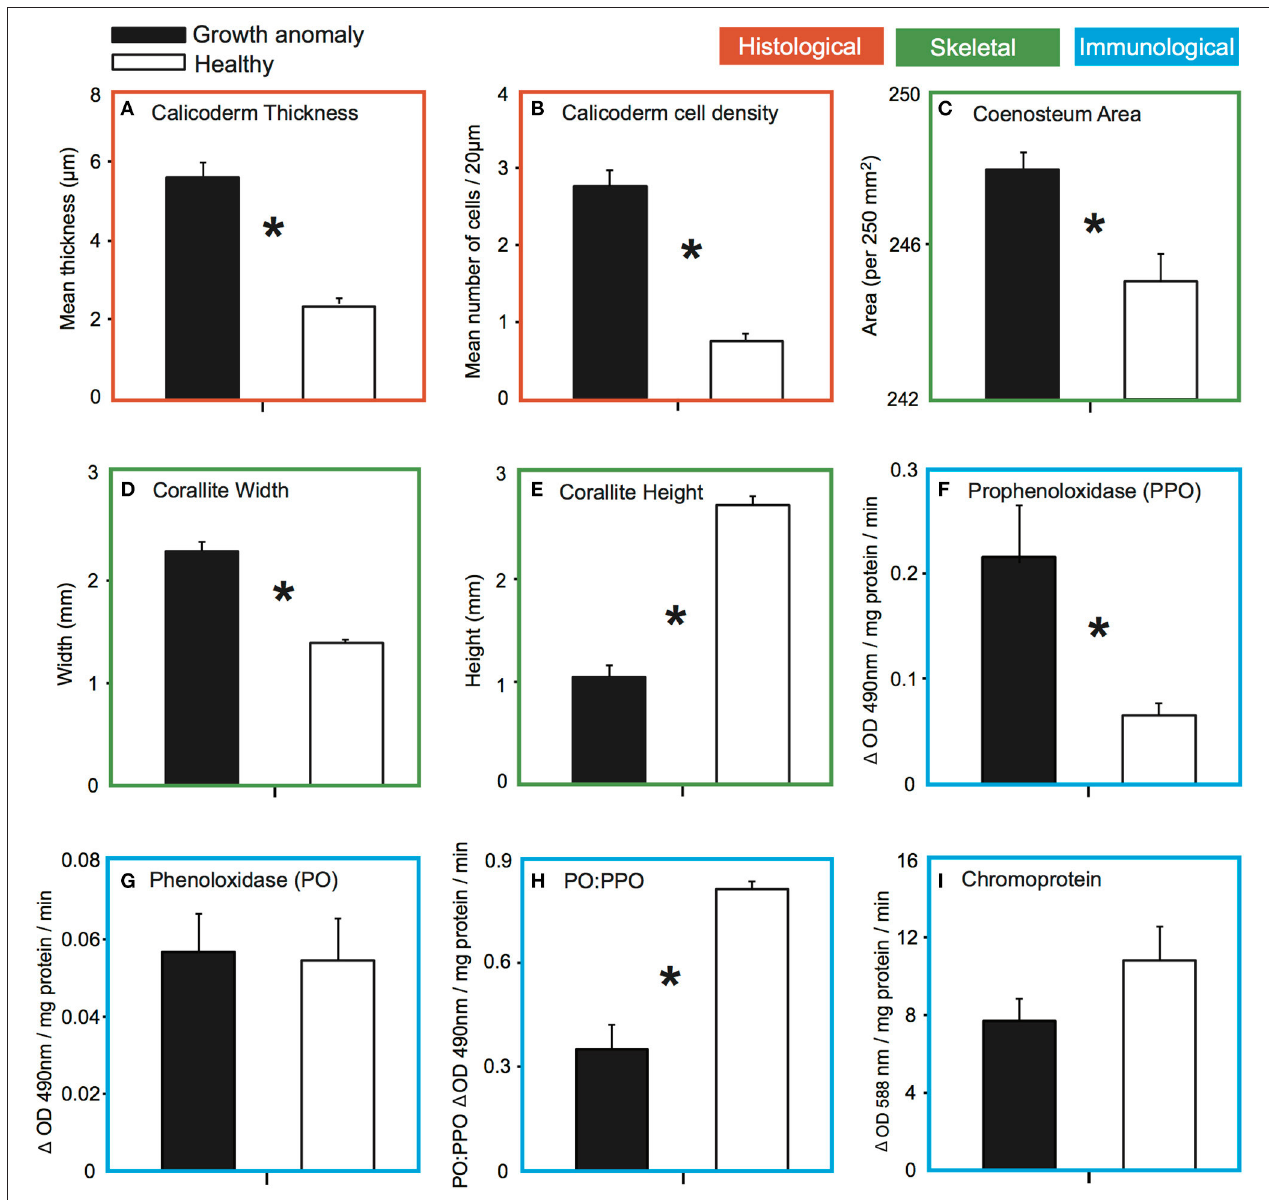
FIGURE 4 | Comparison of the mean ( ± SE) for: (A) thickness of the calicodermal layer of growth anomaly ( n = 15) and healthy tissue ( n = 15); (B) density of calicodermal cells within the calicodermal layer of growth anomaly ( n = 15) and healthy tissues ( n = 15); (C) surface area of the coenosteum per 250mm 2 from skeletal regions with growth anomalies ( n = 15) vs. healthy regions ( n = 15); (D) corallite width and (E) height in skeletal regions of branches with growth anomalies ( n = 11) vs. without growth anomalies ( n = 8); (F) change in enzymatic prophenoloxidase and (G) phenoloxidase activity permg of protein of tissues with growth anomalies ( n = 11) vs. healthy tissues ( n = 8); (H) conversion (ratio) of prophenoloxidase to phenoloxidase between growth anomaly ( n = 11) and healthy ( n = 8) tissue; and the (I) amount of chromoprotein in growth anomaly ( n = 11) and healthy ( n = 8) tissue samples of A. muricata . Asterisks indicate significant differences for α = 0.05.